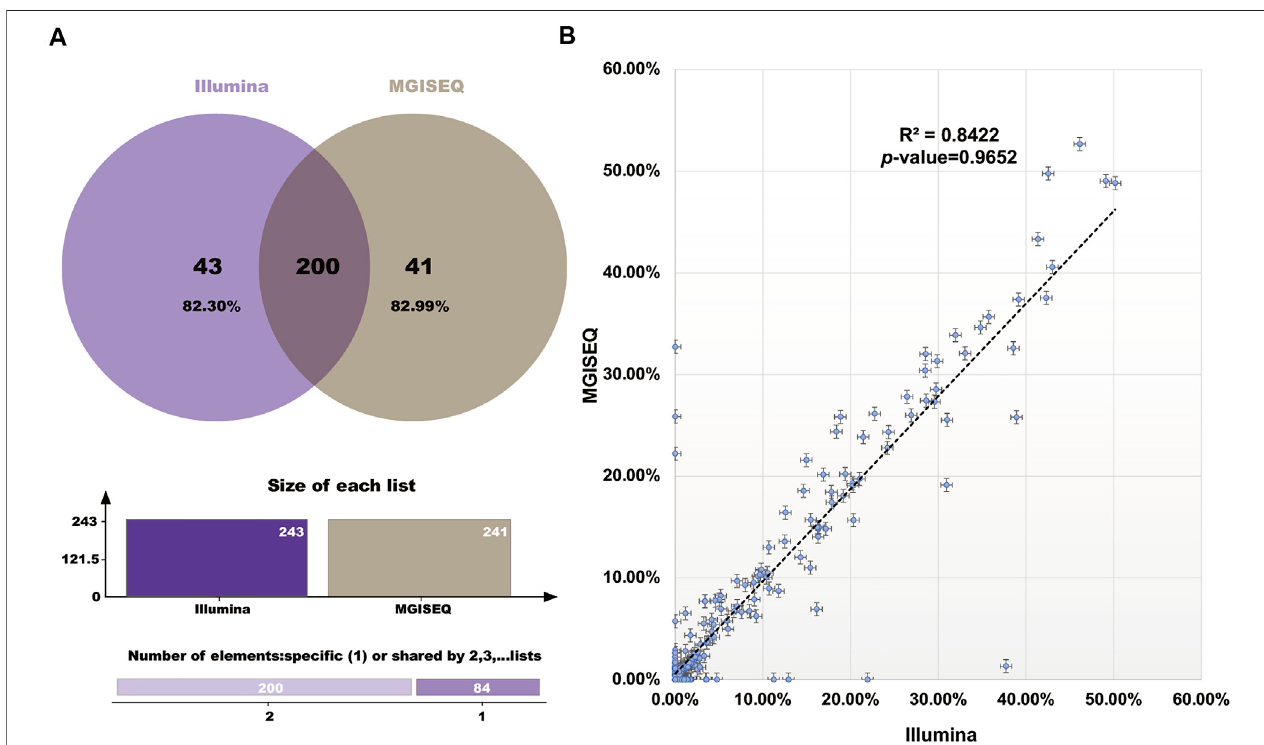
FIGURE 2 | Hotspot Mutation Results Comparison between the Illumina and MGISEQ-2000 Platforms. (A) The Venn digram of the detected hotspot mutations comparision. (B) The correlation comparison of the detected hotspot mutation frequency values.